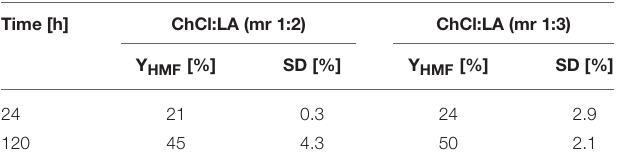
TABLE 2 | 5-Hydroxymethylfurfural (HMF) yields in choline chloride:levulinic acid (ChCl:LA) in a molar ratio of 1:2 and 1:3; reaction temperature: 343K; fructose starting concentration: 2.5 wt.%; pressure: 1 bar.